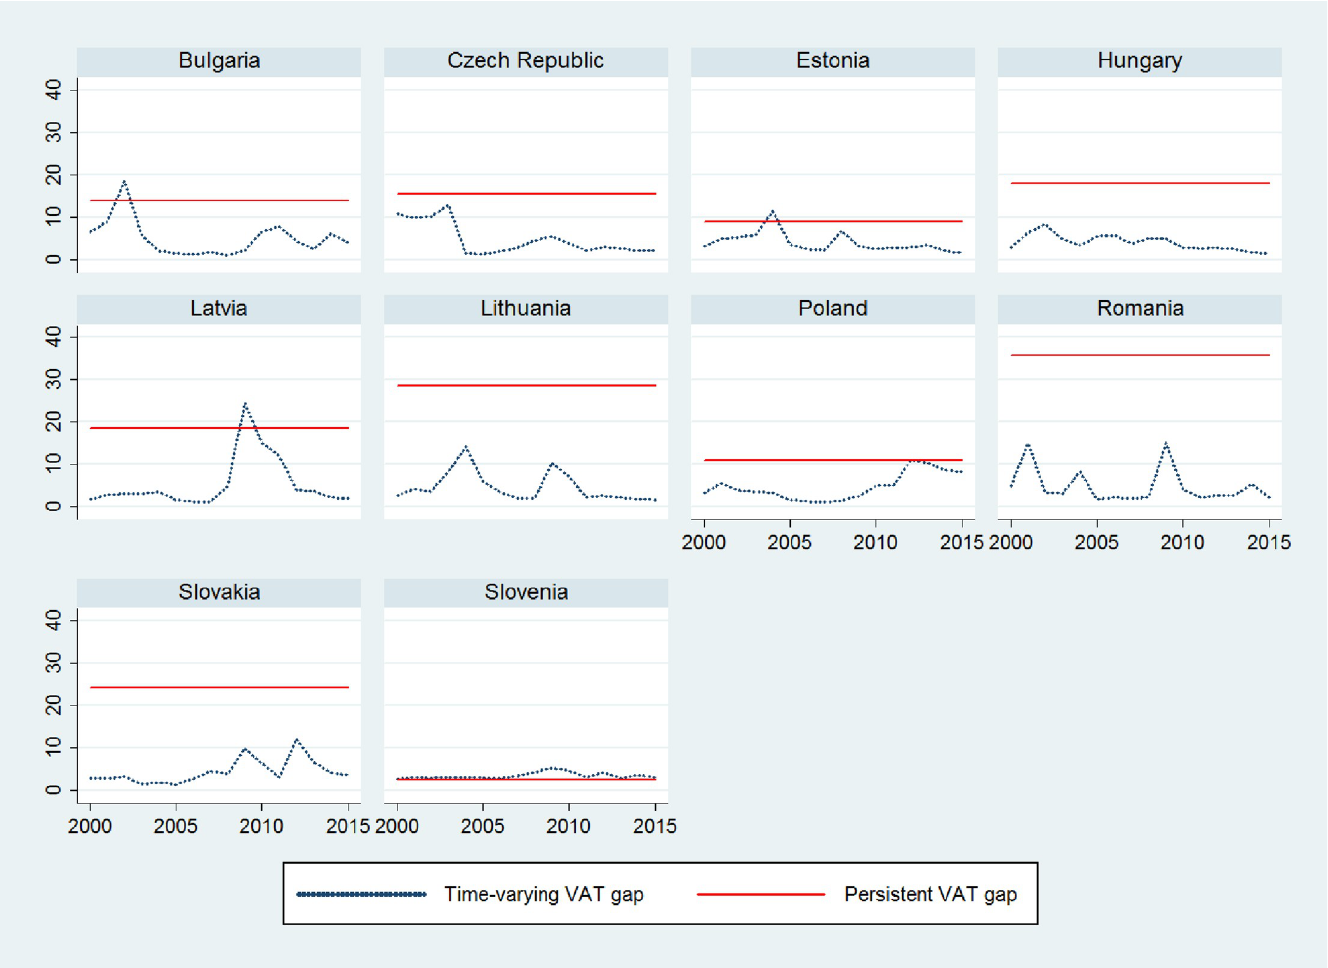
Fig 3. Time-varying VAT gap and persistent VAT gap in the eastern group of EU countries. The blue dotted line represents the time-dependent Value Added Tax gap and the red line represents the country-specific or persistent Value Added Tax gap, between 2005–2015. The persistent and time-dependent VAT gap was generated in STATA after the STFM